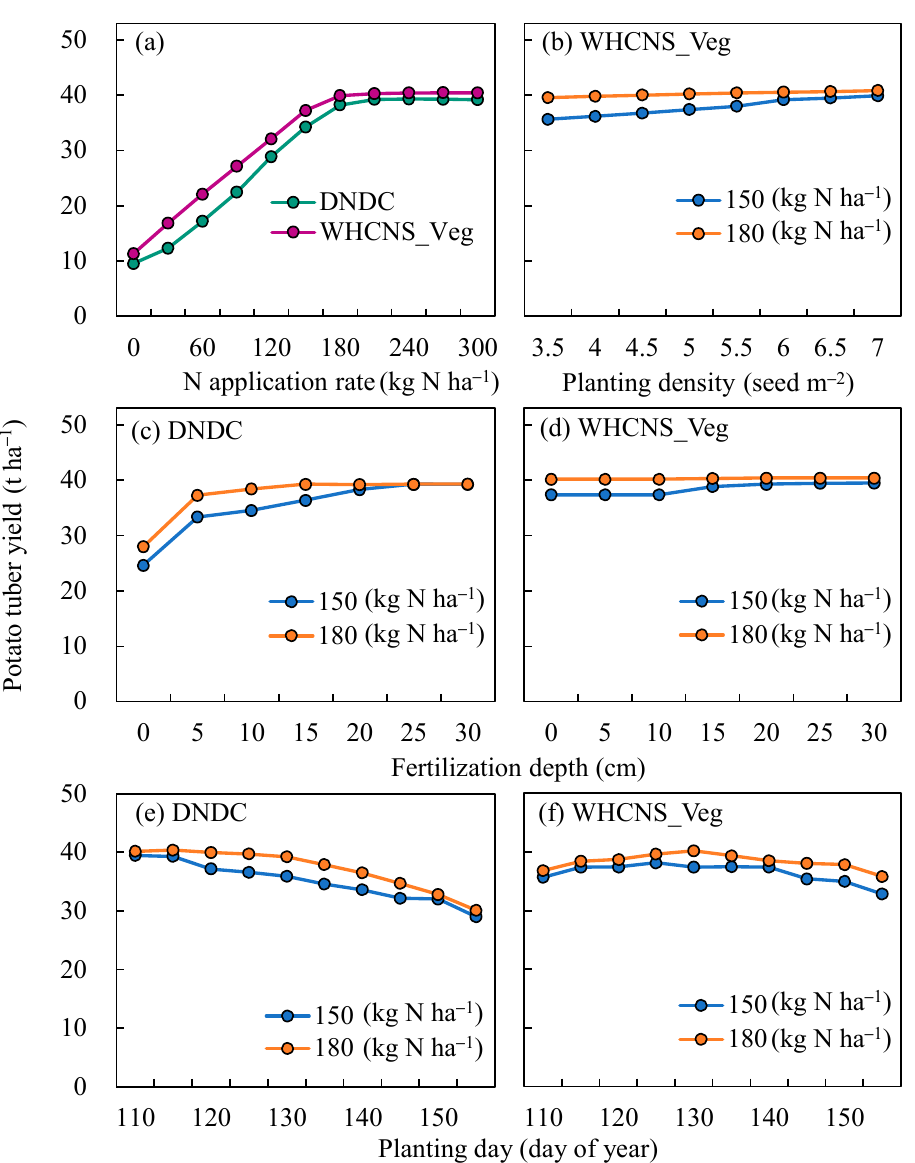
Figure 6. Sensitivity of potato tuber yield to ( a ) N application rate, ( b ) planting density, ( c , d ) fertilization depth, and ( e , f ) planting day from 1981 to 2020 using the DNDC and WHCNS_Veg models in Wuchuan,